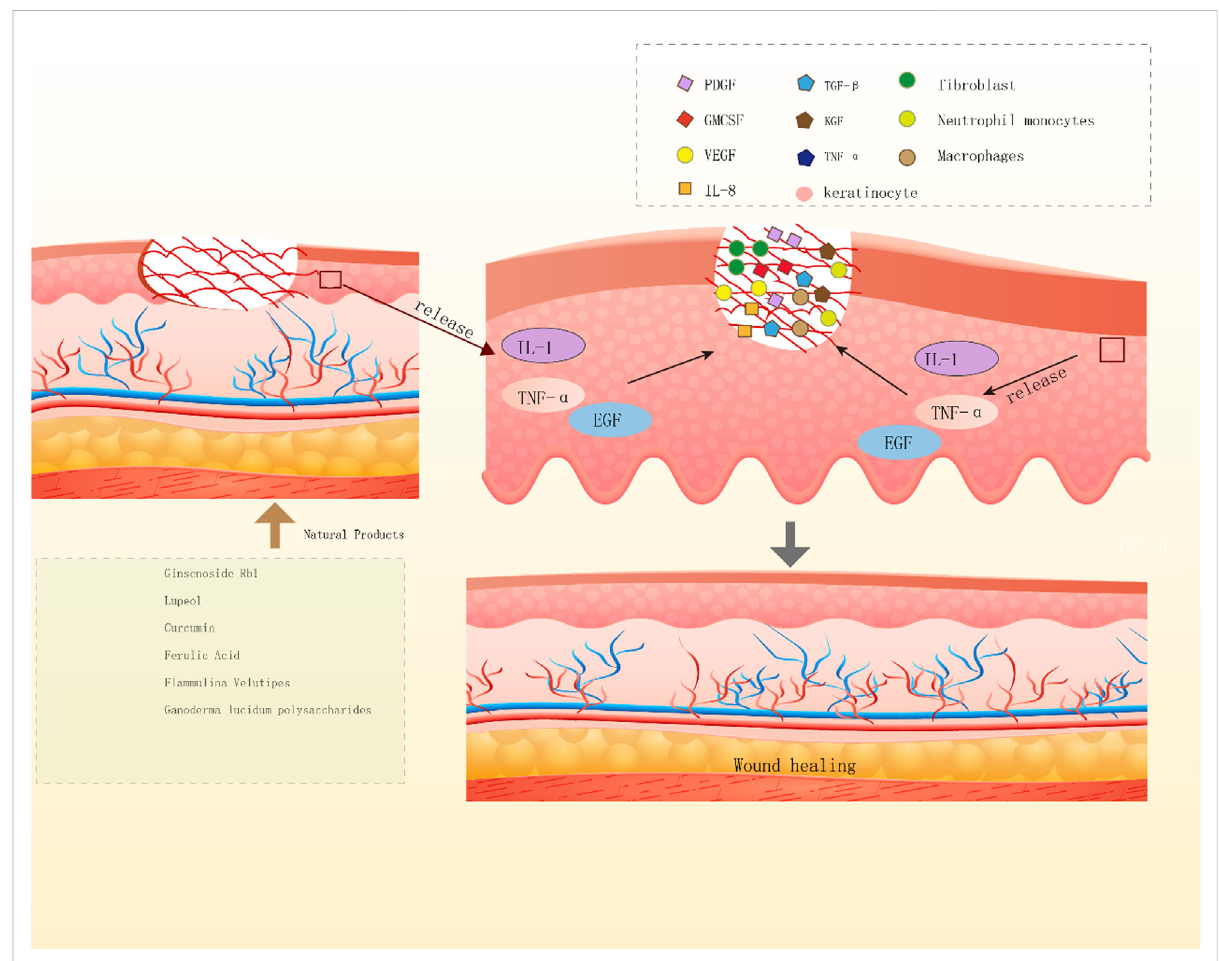
FIGURE 4 Diagram of the mechanisms by which natural products promote wound re epithelialization. Ginscnoside Rb1, lupeol, curcumin, ferulic acid, Flammulina velutipes, Ganoderma lucidum polysaccharides, the above six natural products release IL-1, TNF - α and EGF by keratinocytes to promotes wound re